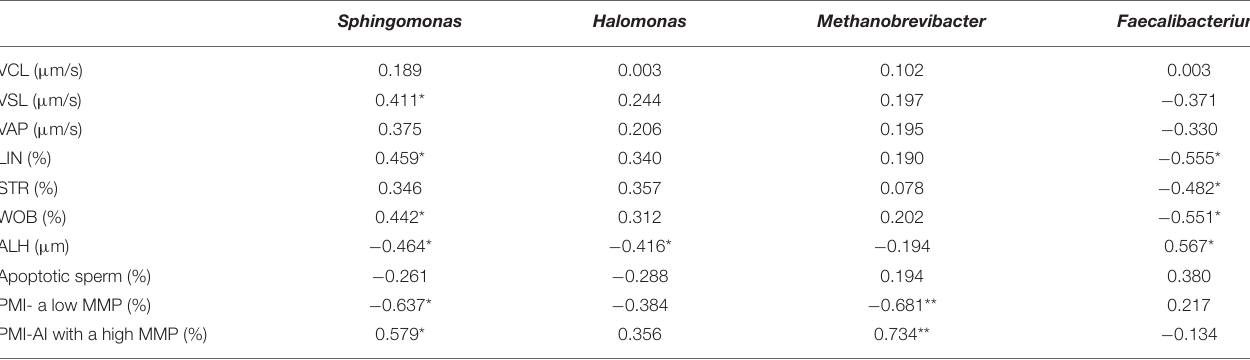
TABLE 3 | Spearman’s rank correlation coefficients between the mean relative abundance of the genera Sphingomonas, Halomonas, Methanobrevibacter , and Faecalibacterium and the sperm quality parameters of goat buck